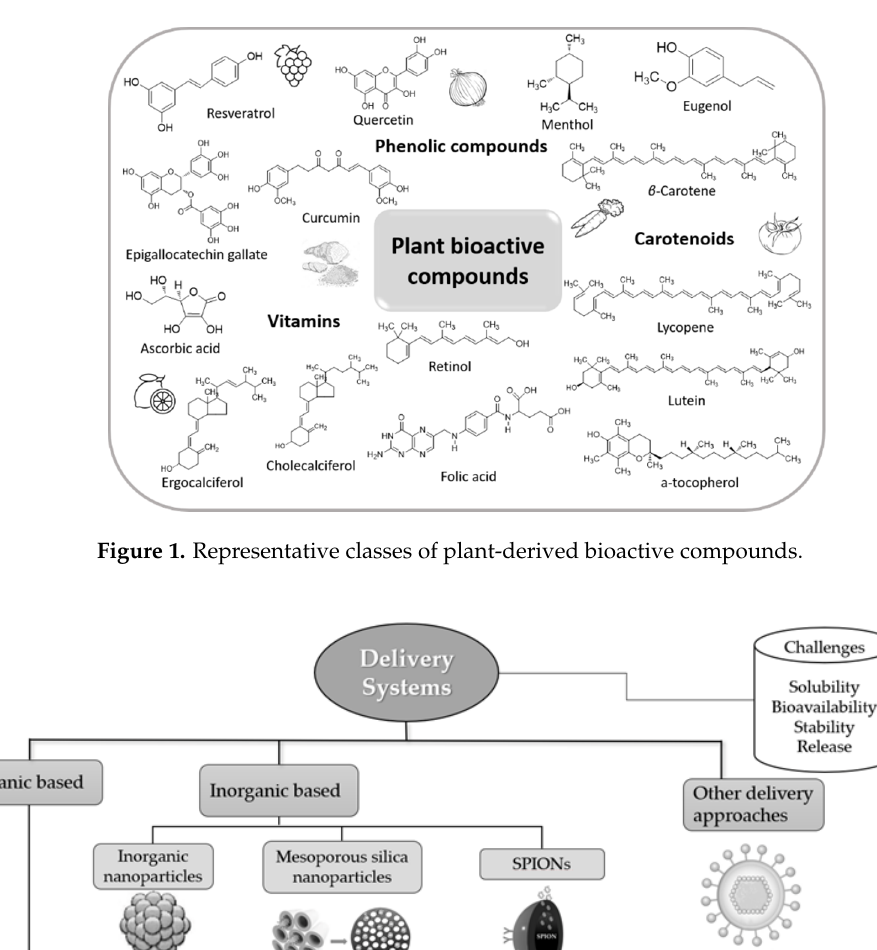
Figure 1. Representative classes of plant-derived bioactive compounds.